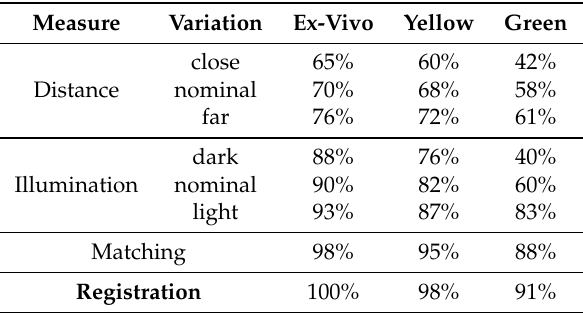
Table 2. Qualitative Measure